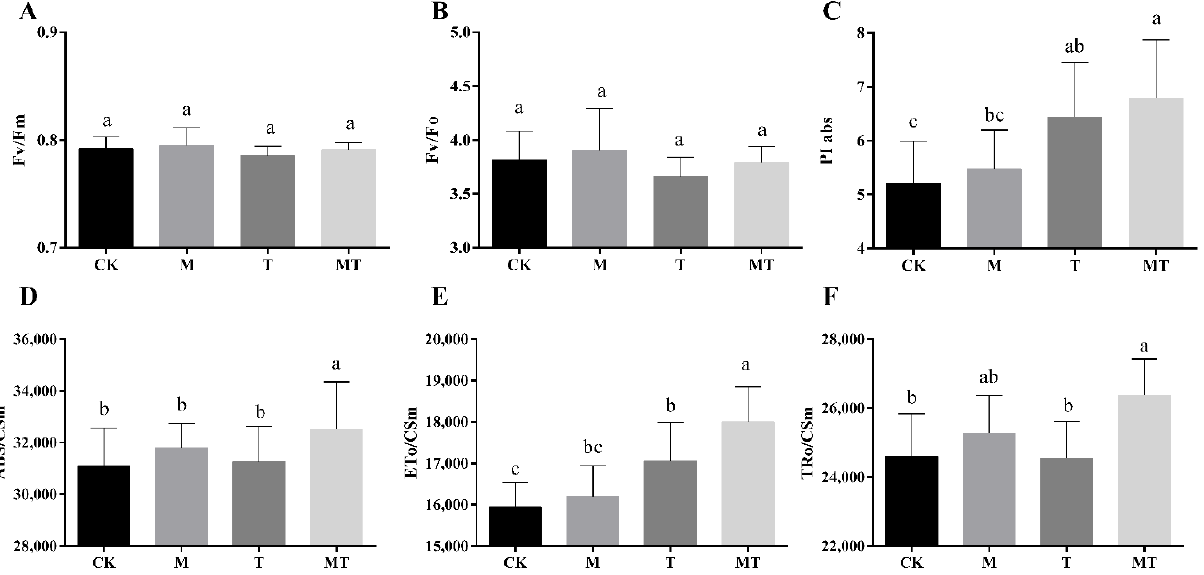
Figure 3. Changes of chlorophyll fluorescence parameters of melatonin pre-treated and non-treated ‘Brazil’ banana before and after cold stress. ( A ) F v /F m : the maximum photochemical efficiency PS II of photosystem II; ( B ) F v /F o : the potential photosynthetic efficiency of PS II; ( C ) PI abs: light energy absorption performance index; ( D ) ABS/CSm: absorbed light energy per unit area at the end; ( E ) TRo/CSm: captured light energy per unit area at the end; ( F ) ETo/CSm: electron transfer quantum yield per unit area at the end. Different letters above bars indicate a significant difference among samples determined using Duncan’s test at the p < 0.05 level. All the data are displayed as mean ± standard deviation for nine replications. CK: control; M: melatonin treatment; T: low-temperature treatment; MT: combined melatonin and low-temperature treatment.